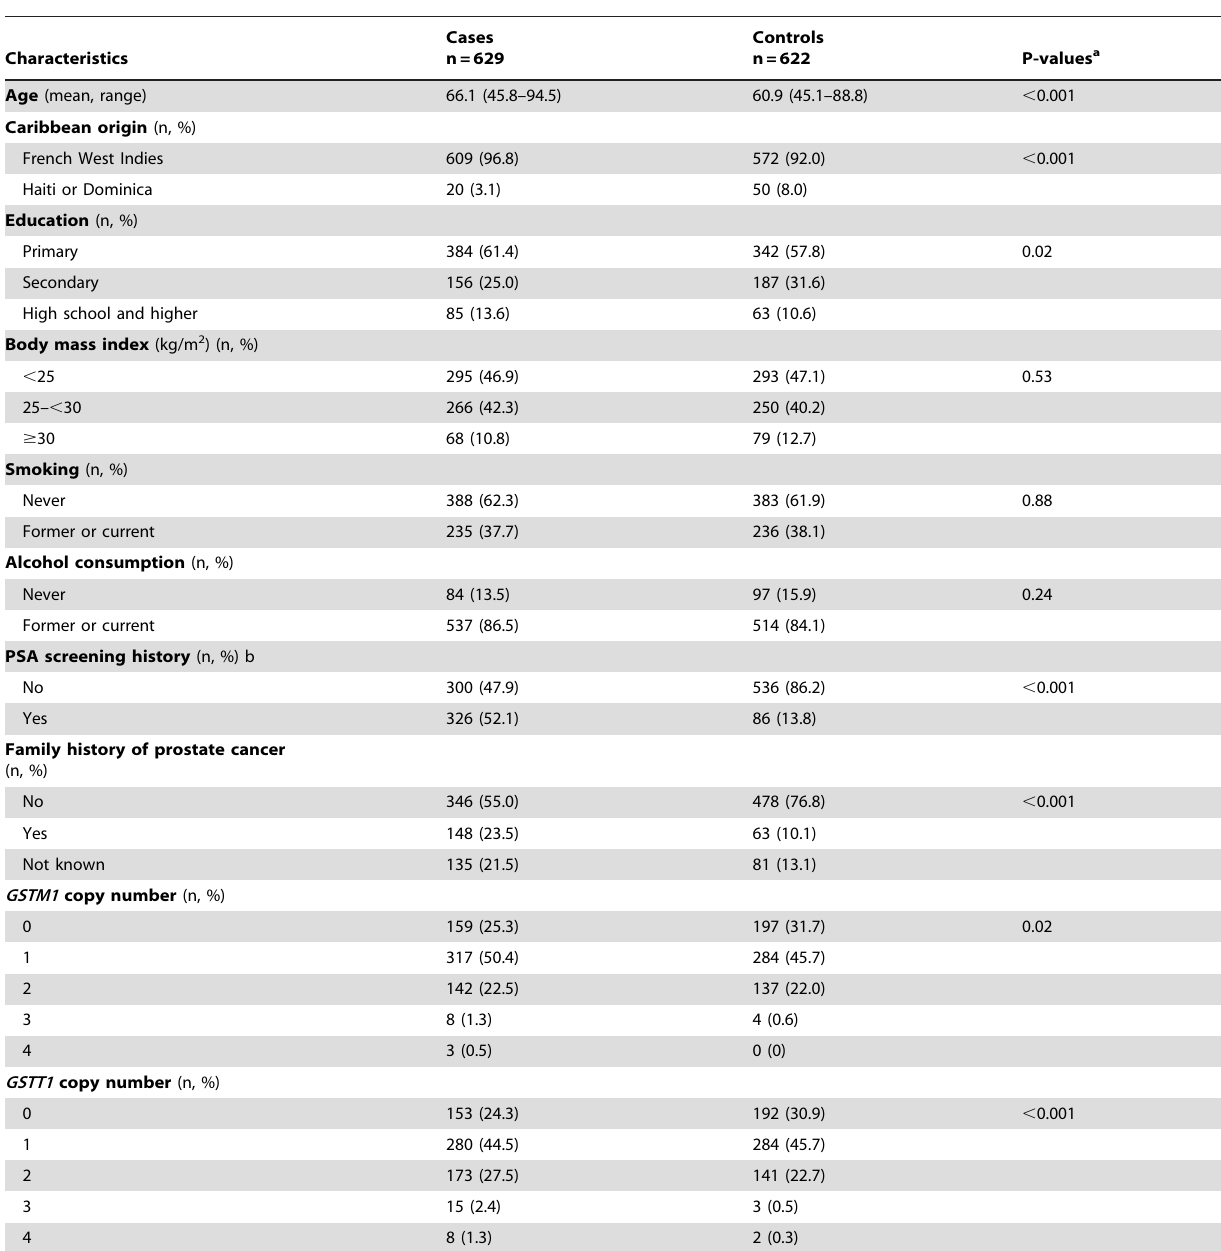
Table 1. Baseline characteristics of the study